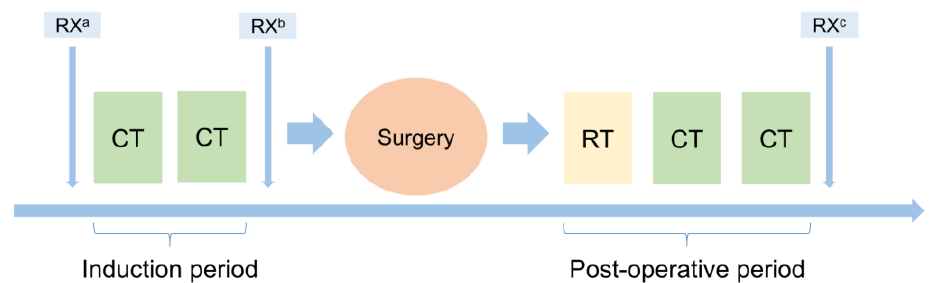
Figure 1. Protocol scheme. RX: baseline a , post-induction b and first follow-up c radiological evaluation; CT: chemotherapy; RT: radiotherapy.